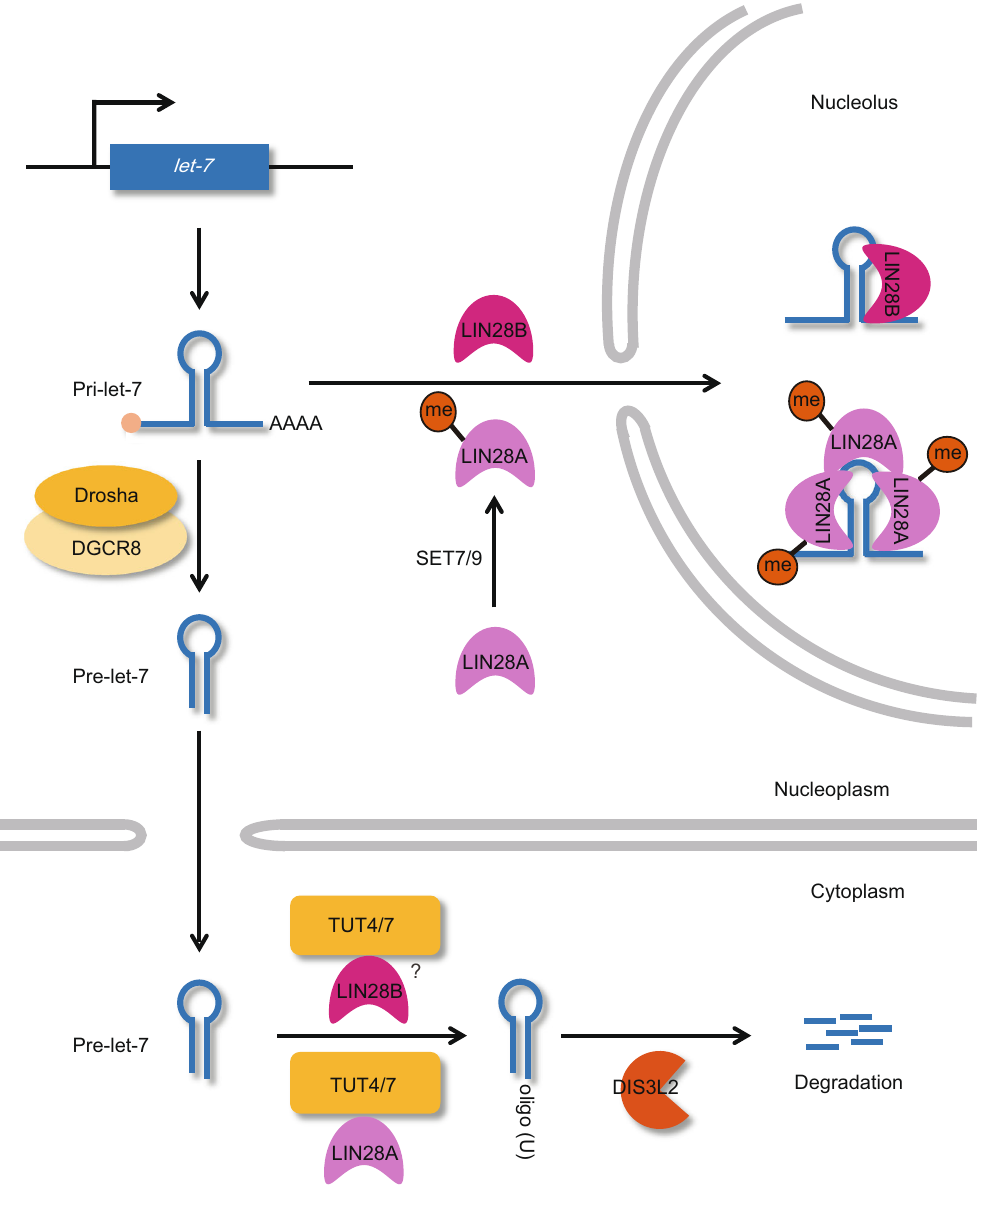
Figure 4. Regulation of let-7 biogenesis by LIN28A/B. LIN28A and LIN28B inhibit the biogenesis of let-7 via both TUTase- dependent and -independent pathways. LIN28A helps TUTases to oligo-uridylate pre-let-7 . Methylated LIN28A binds to pri-let-7 in the nucleus and sequesters it into the nucleolus to prevent Drosha-mediated processing. LIN28B blocks the biogenesis of the let-7 miRNA via TUTase-independent pathways. The detailed relationship between LIN28B and TUTases needs to be further